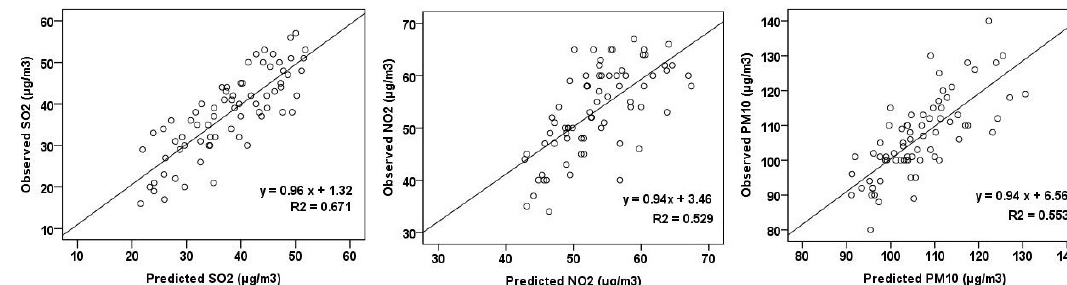
Figure 5. Scatter plots of leave-one-out-cross-validation (LOOCV) results.